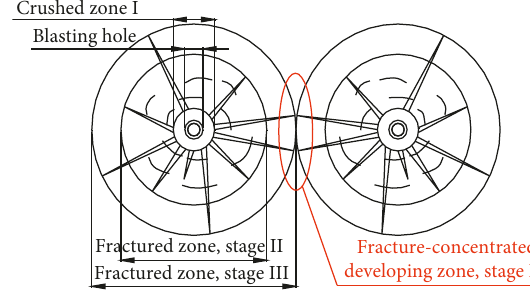
Figure 8: Blasting fracturing